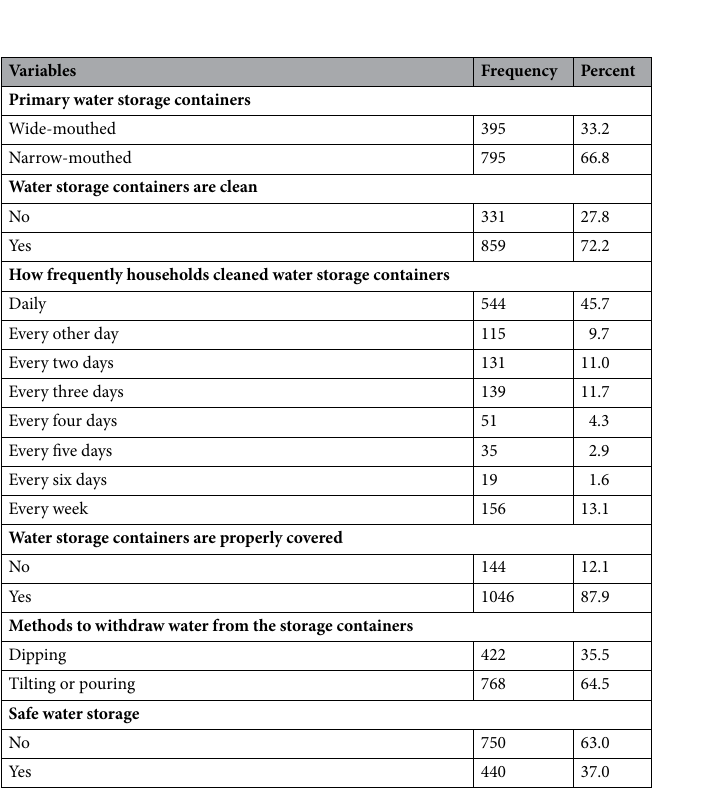
Table 3. Water handling practices of households (n = 1190) in a rural setting of northwest Ethiopia, May